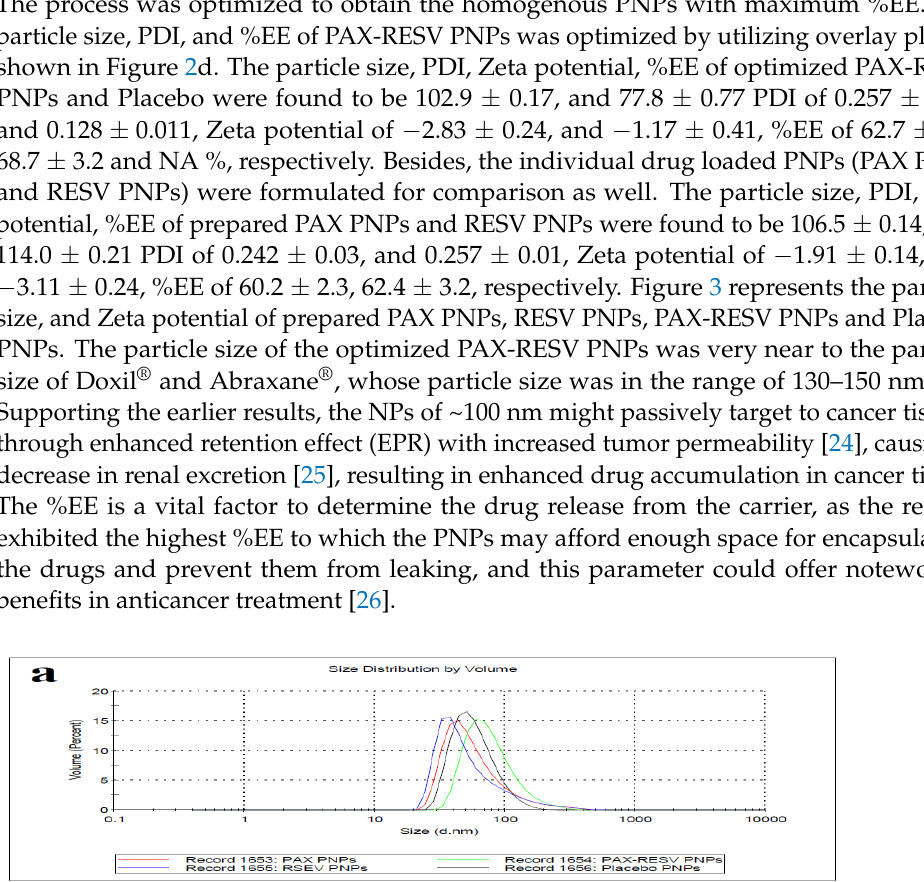
Figure 4. ( I ) FT-IR Spectrum of ( A ) PAX; ( B ). RESV; ( C ) Placebo; ( D ) PAX PNPs; ( E ) RESV PNPs; ( F ) PAX-RESV PNPs: ( II ) PXRD Analysis of ( A ) PAX; ( B ) RESV; ( C ) Placebo; ( D ) PAX PNPs; ( E ) RESV PNPs; ( F ) PAX-RESV PNPs: ( III ) The SEM images analysis of PAX-RESV PNPs. 3.4. Fourier Transform Infrared (FT-IR) Spectroscopy The FT-IR of Pure PAX, RESV, Placebo, PAX-RESV PNPs, PAX, and RESV PNPs was shown in Figure 4I(A–F) and their corresponding characteristic peak positions are listed in Table 3. The data obtained confirms the presence of this characteristic’s peaks in PAX PNPs, RESV PNPs and PAX-RESV PNPs (Figure 4I(D–F)) matching to the peaks of the pure drugs (Figure 4I(A,B)) without any major shifts. Thus, FT-IR studies concluded pol- ymer drug compatibility.